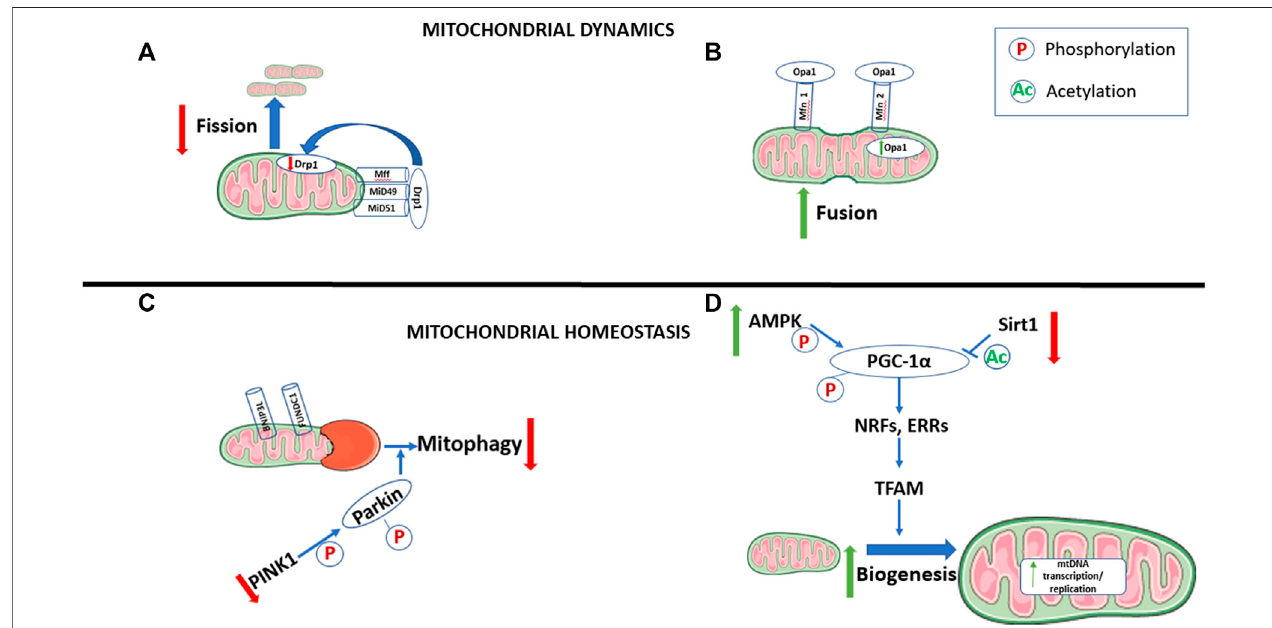
FIGURE 1 | Changes in mitochondrial dynamics and homeostasis during cell maturation. During the maturation of cells that are transitioning from a proliferating to differentiated state,thereisanincrease inmitochondrialfusion (A) andbiogenesis (D) ,withdecreasesinmitophagy (C) andmitochondrial fi ssion (B) .Pathwaysinvolved in mitophagy, and fi ssion are also downregulated, while pathways promoting mitochondrial fusion and biogenesis are upregulated. AMP-activated protein kinase (AMPK). BCL2 interacting protein 3 like (BNIP3L). Dynamin-related protein 1 (Drp1). Estrogen-related receptors (ERRs). FUN14 domain-containing-1 (FUNDC1). Mitochondrial fi ssion factor (Mff). Mitofusin 1/2 (Mfn 1/2). Mitochondrial dynamic protein 49/51 (MiD49/51). Mitochondrial DNA (mtDNA). Nuclear respiratory factors (NRFs). Optic atrophy 1 (Opa1). Peroxisome proliferator-activated receptor- γ coactivator-1 α (PGC-1 α ). Phosphatases and tensin homolog (PTEN)-induced